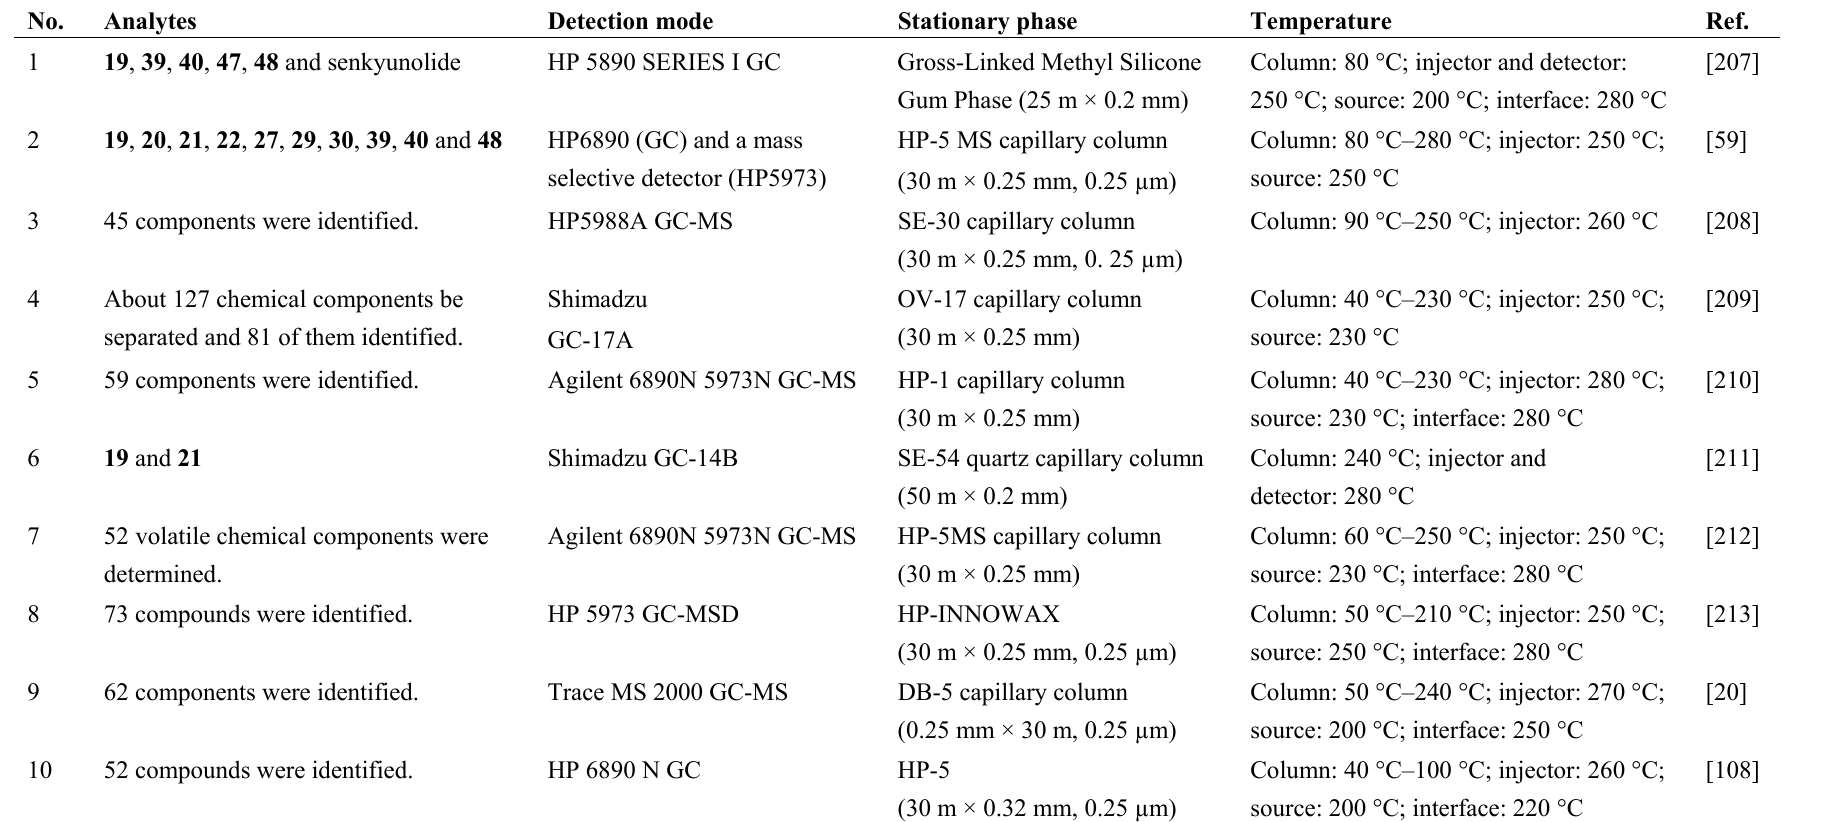
Table 7. GC-MS methods developed for the chemical analysis of